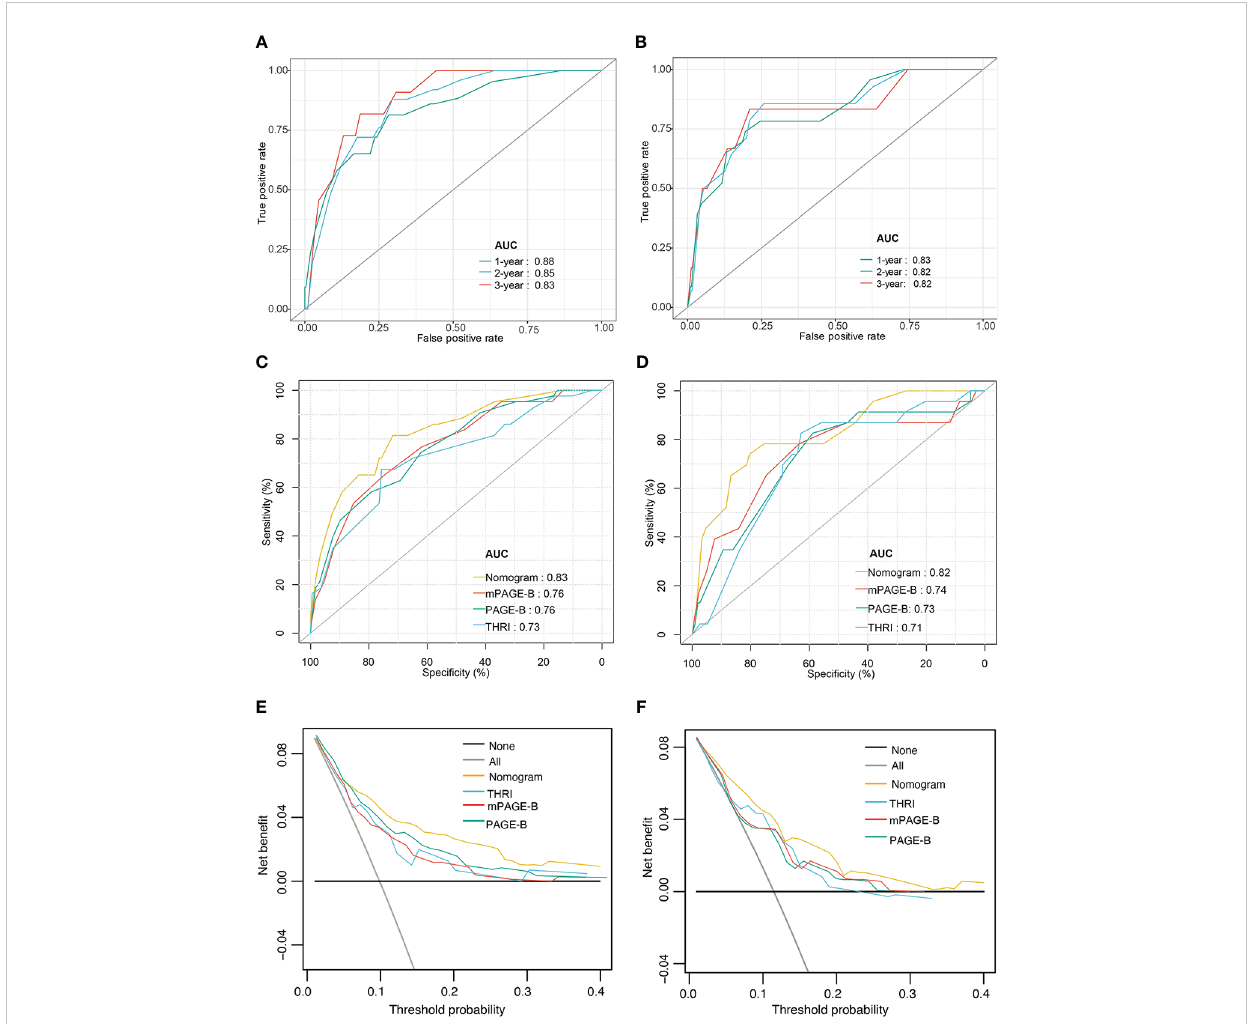
FIGURE 3 Performance of nomogram model. Time – dependent area under the ROC curve for the HCC risk prediction of patients with hepatitis-B related cirrhosis in the derivation (A) and the validation cohorts (B) ; The ROC curves of nomogram, mPAGE-B, PAGE-B, and THRI in prediction of 3-year HCC occurrence in the derivation (C) and the validation cohorts (D) ; Decision curve analysis for predicting HCC occurrence in the derivation (E) and the validation cohorts (F) . ROC, receiver operating characteristic; HCC, hepatocellular carcinoma; mPAGE-B, modi fi ed PAGE-B scores; PAGE-B, platelet age gender-B; THRI, Toronto HCC risk